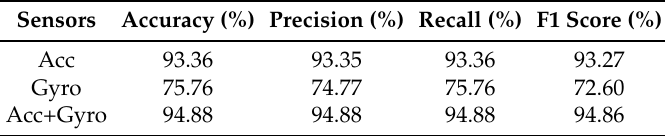
Table 7. Performance comparison of adopting different sensors.